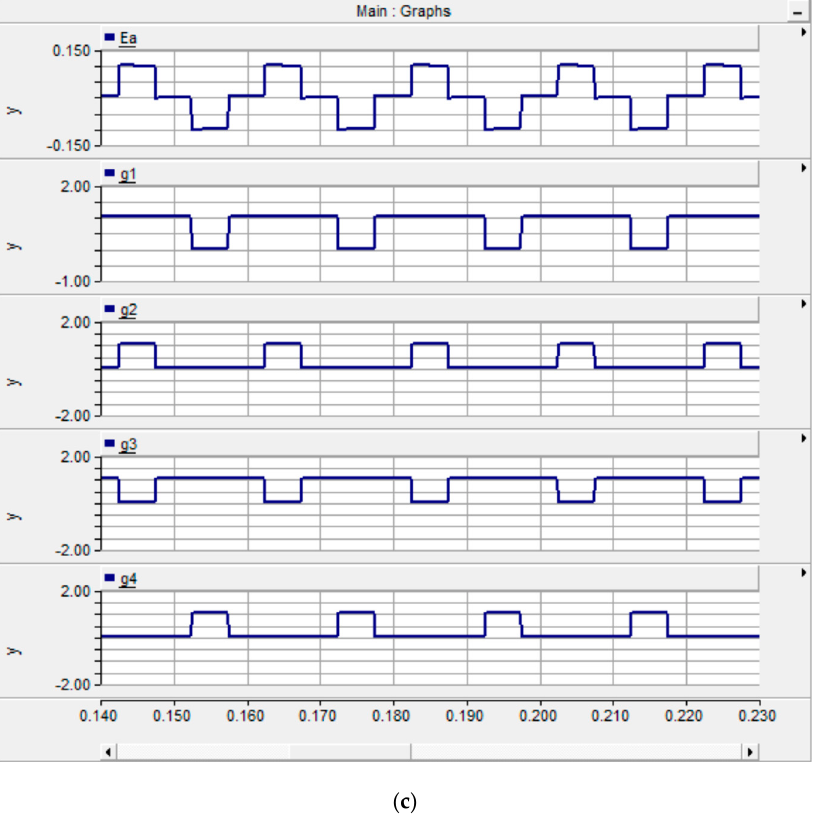
Figure 10. ( a ) Power circuit of 3- level FC-MLI; ( b ) control circuit of 3- level FC-MLI; ( c ) phase output voltage waveform of 3-level FC-MLI.